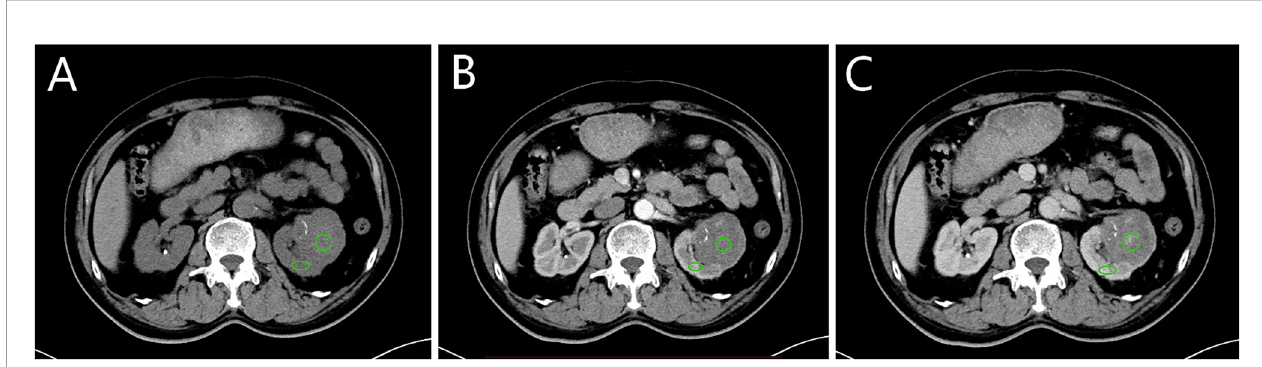
FIGURE 1 | Selection of region of interests (ROIs) and reference region. (A – C) correspond to the non-enhanced, corticomedullary phase (CMP) and nephrographic phase (NP). The green circle is one of two tumour ROIs, selected from the parenchymal portion of the tumour where enhancement is evident. The green oval is the reference region located in the cortical portion of the kidney. The zones of ROIs and reference region are in the same position in each scan